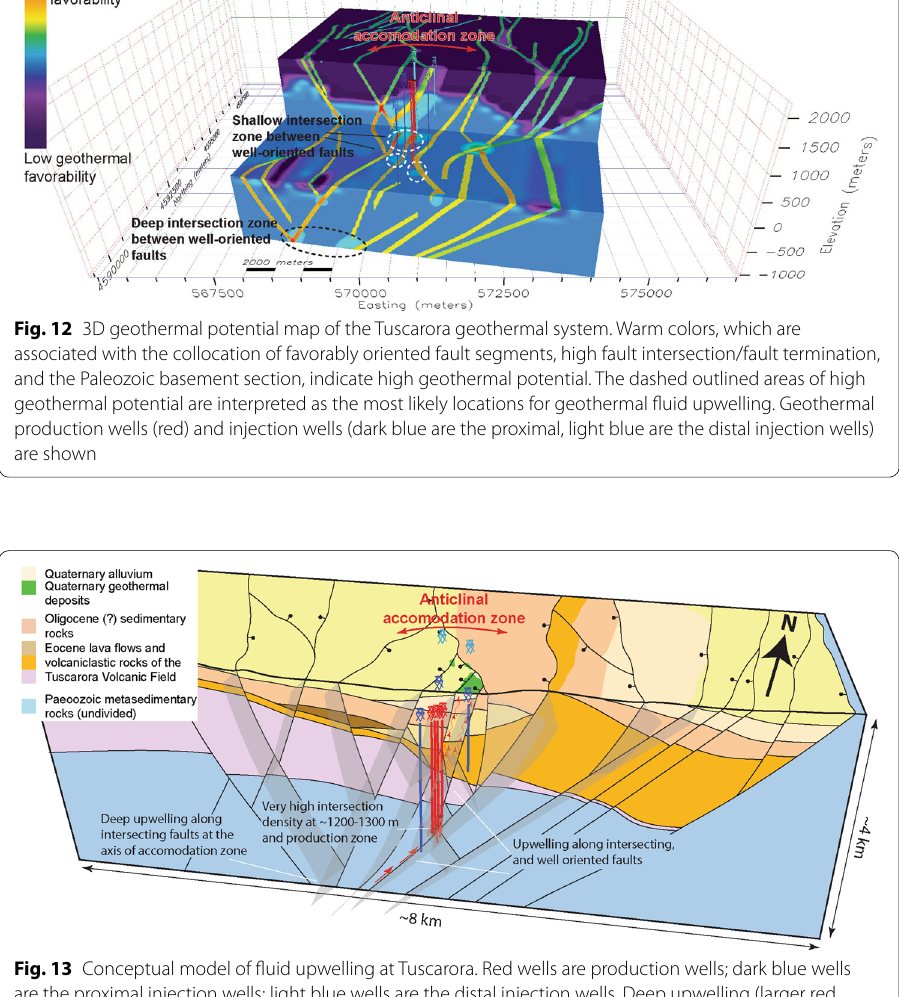
The normalized slip tendency map, dilation tendency map, and intersection density maps are summed to produce a 3D map of the proxies related to structural permeability.